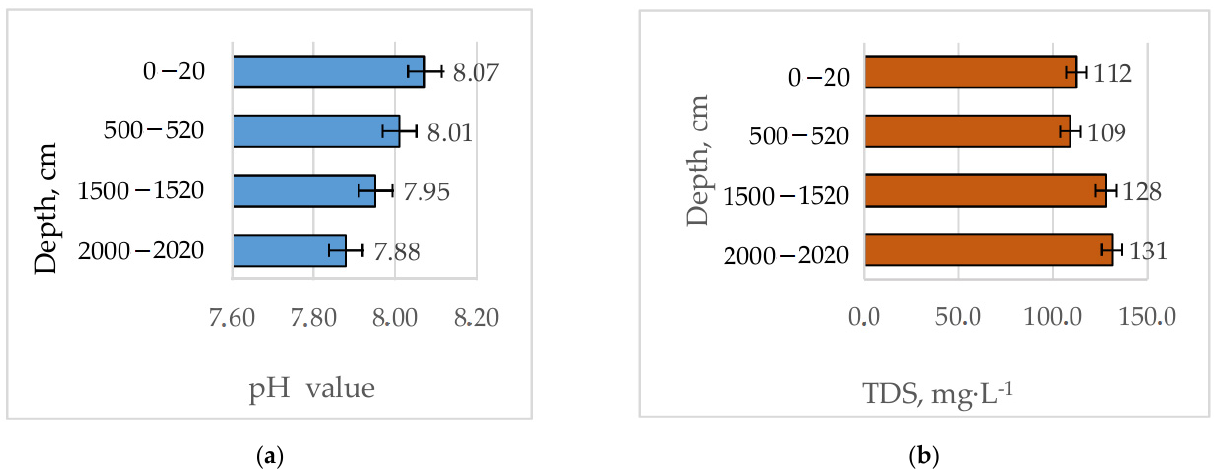
Figure 2. Distribution of pH and TDS (total dissolved solids) at different depths: ( a ) pH value at different depths; ( b ) TDS value at different depths. Whiskers represents the standard error.